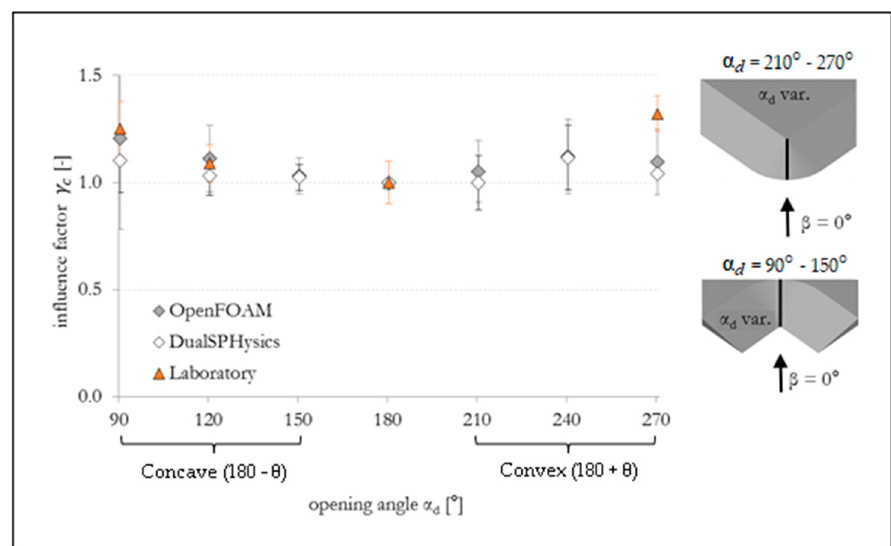
Figure 9. Influence of a curvature in the dike line on wave run-up for perpendicular wave attack–studied position: center of curvature.